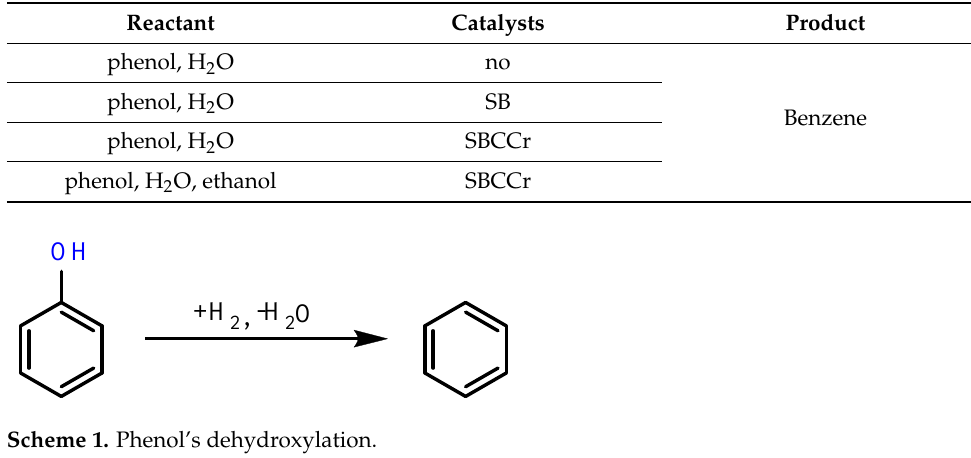
Figure 13. Distributions of saturated hydrocarbons after reaction under different conditions.